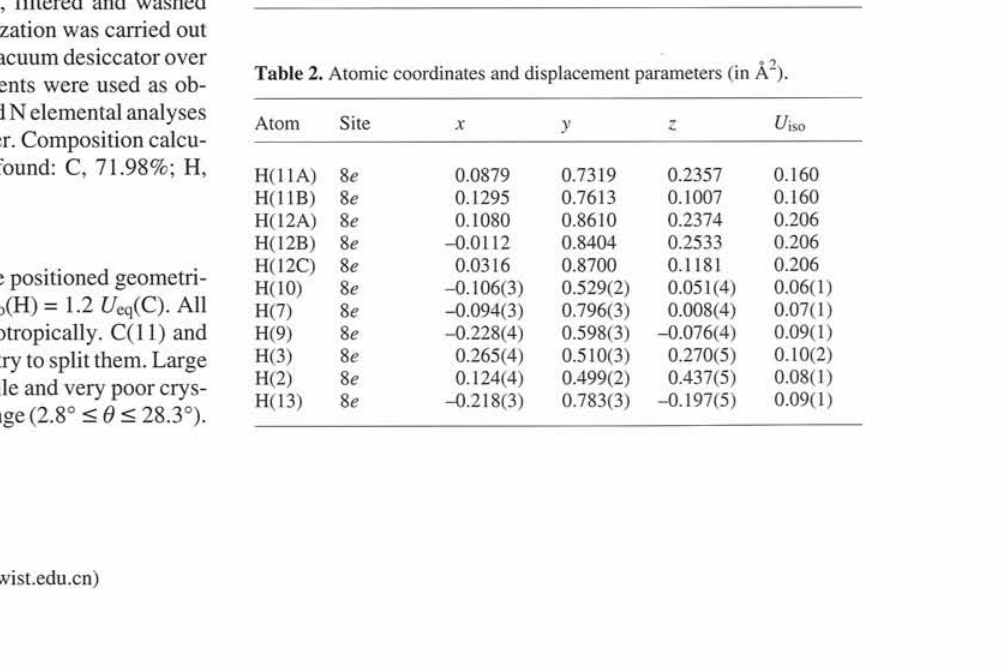
Table 2. Atomic coordinates and displacement parameters (in A